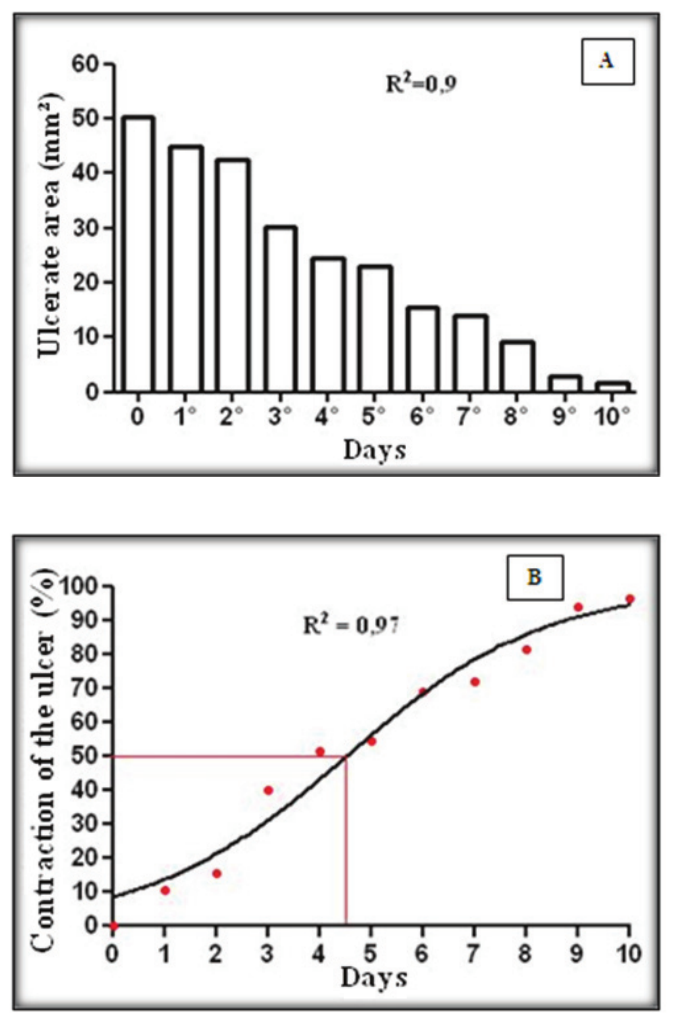
FIGURE 5 - Area with trauma- induced ulcers in the cheek mucosa of rats. ( A ) Relation between the area of the ulcer and time was analyzed by ANOVA test with Tendency post-test (R 2 =0.87; p<0.0001). ( B ) Relation of the percentage of ulcer contraction and time (p<0.0001).